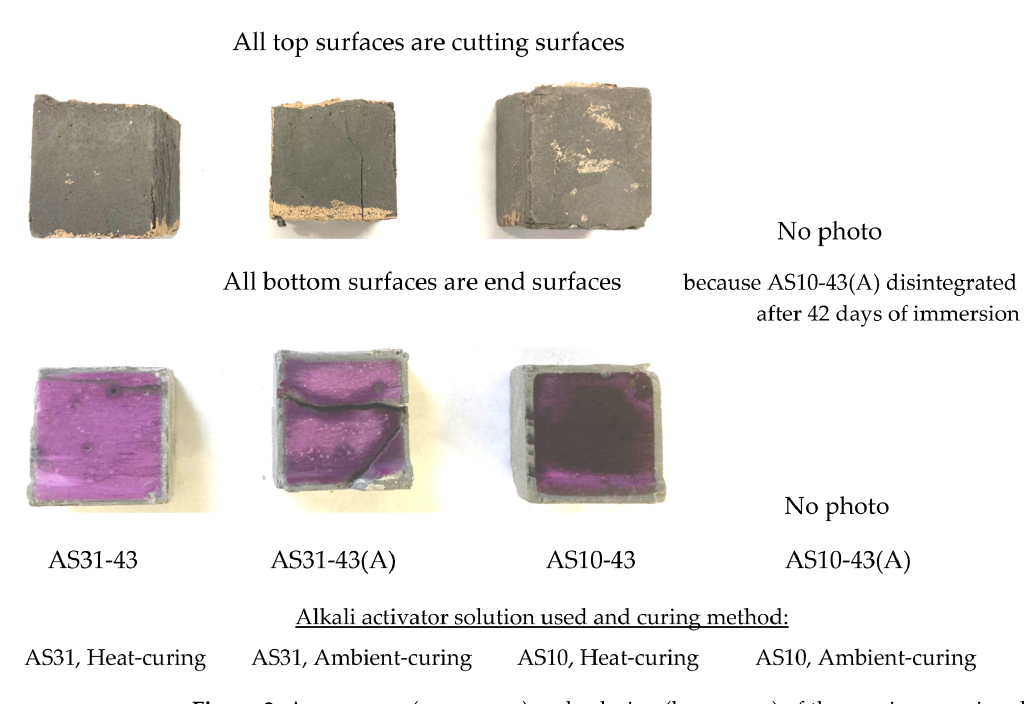
Figure 2. Appearance (upper row) and coloring (lower row) of the specimens using different AS and cured by different methods after 84-day immersion (Clay color in the specimens’ surfaces is due to epoxy sealing or its contamination) .